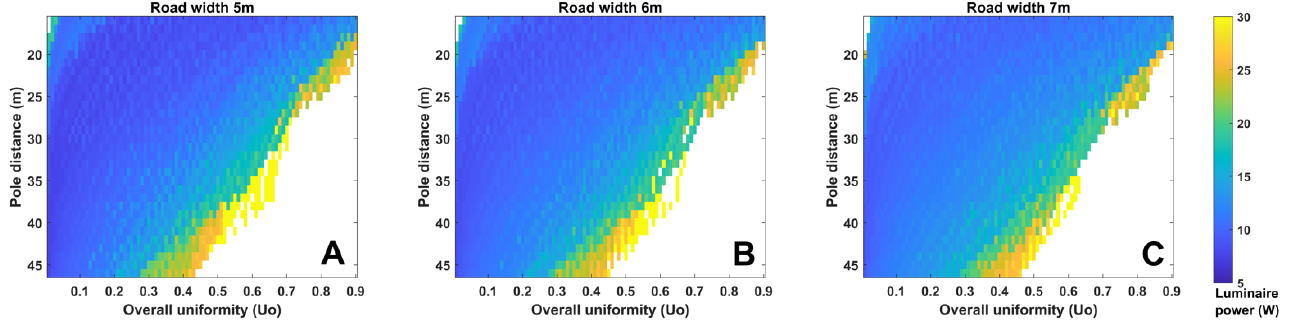
Figure 4. Overall uniformity of illuminance vs. pole distance vs. minimum luminaire power for E m = 10 lx. Dark blue indicates low power, whereas yellowish refers to higher power levels. The white space equals a lack of technical solutions: ( A ) results for road width of 5 m; ( B ) results for road width of 6 m; ( C ) results for road width of 7 m.